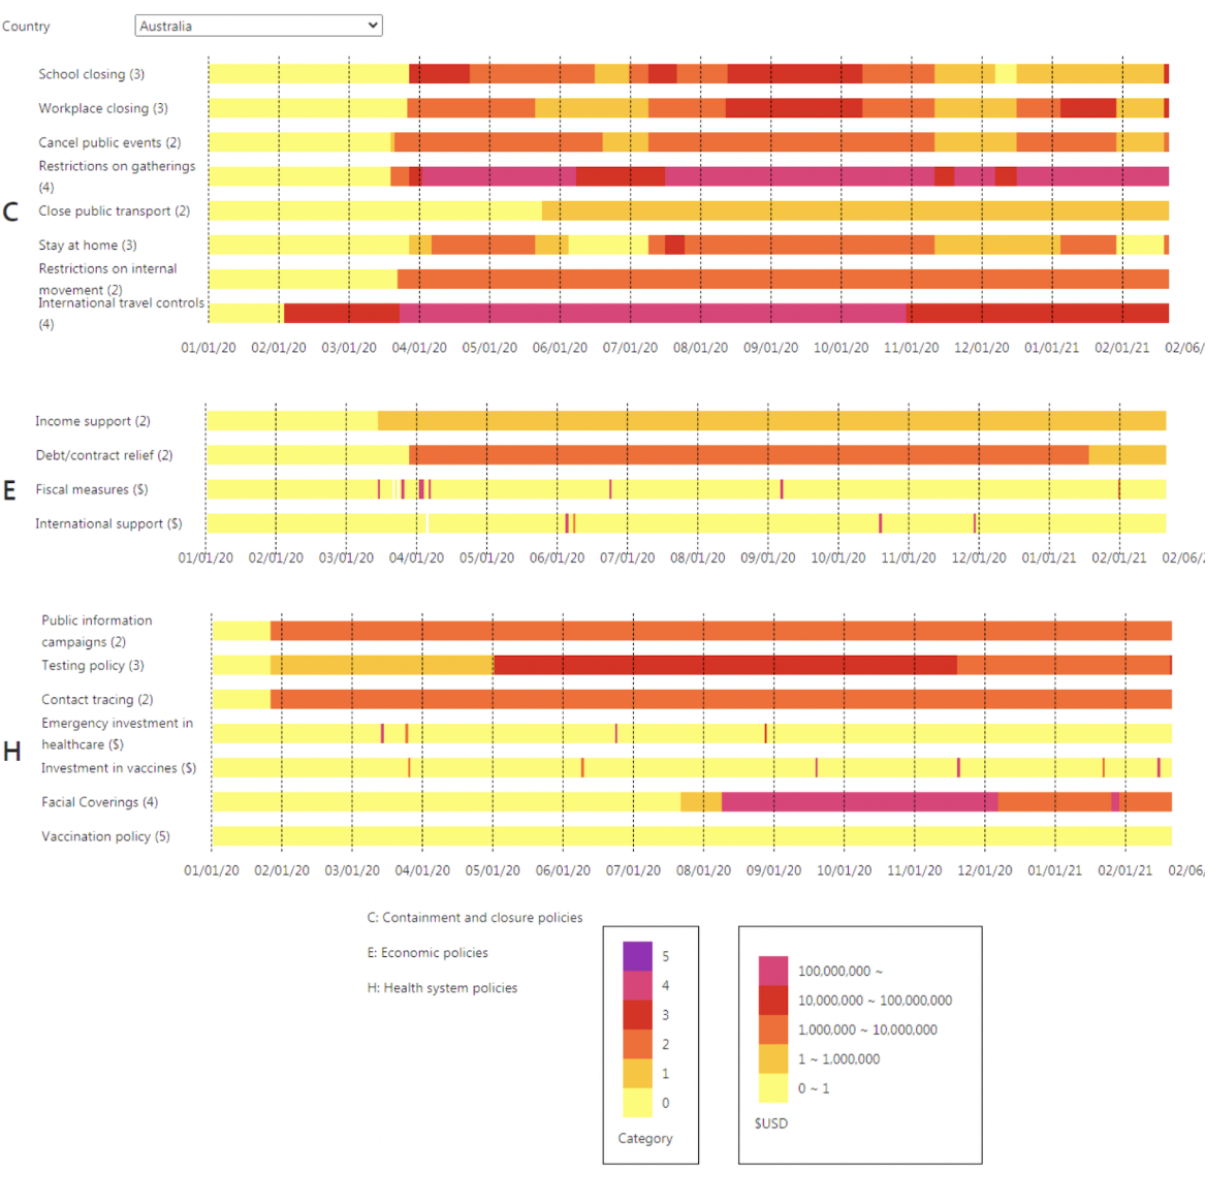
Figure 2. The interface of the dynamic heat map with policy measures on the COVID-19 Pandemic AI System (CPAIS)